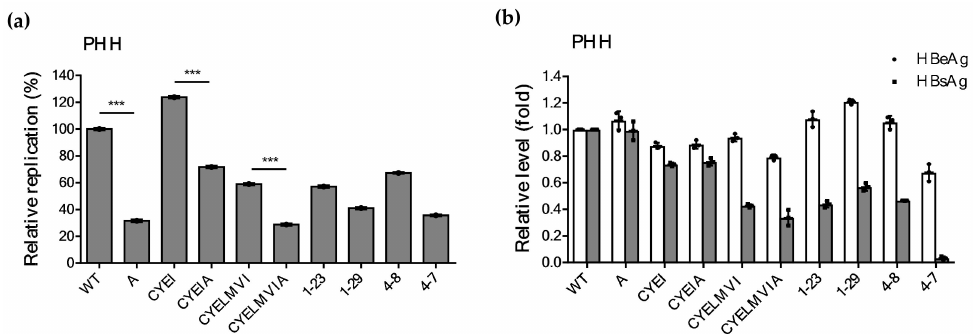
Figure 7. Effect of the rtT301A mutation on replication ability in primary human hepatocytes (PHHs). ( a ) The PHHs were transfected with 5 µ g of indicated HBV replicons using Lipofectamine 3000. Four days later, the cells were harvested for the analysis. The replication capacity of each clone was determined by quantitative real-time PCR. *** p < 0.001. ( b ) Secreted HBeAg and HBsAg levels of indicated clones were determined by ELISA. Single-donor hepatocytes were used in this experiment. Data in ( a , b ) were obtained from three biological